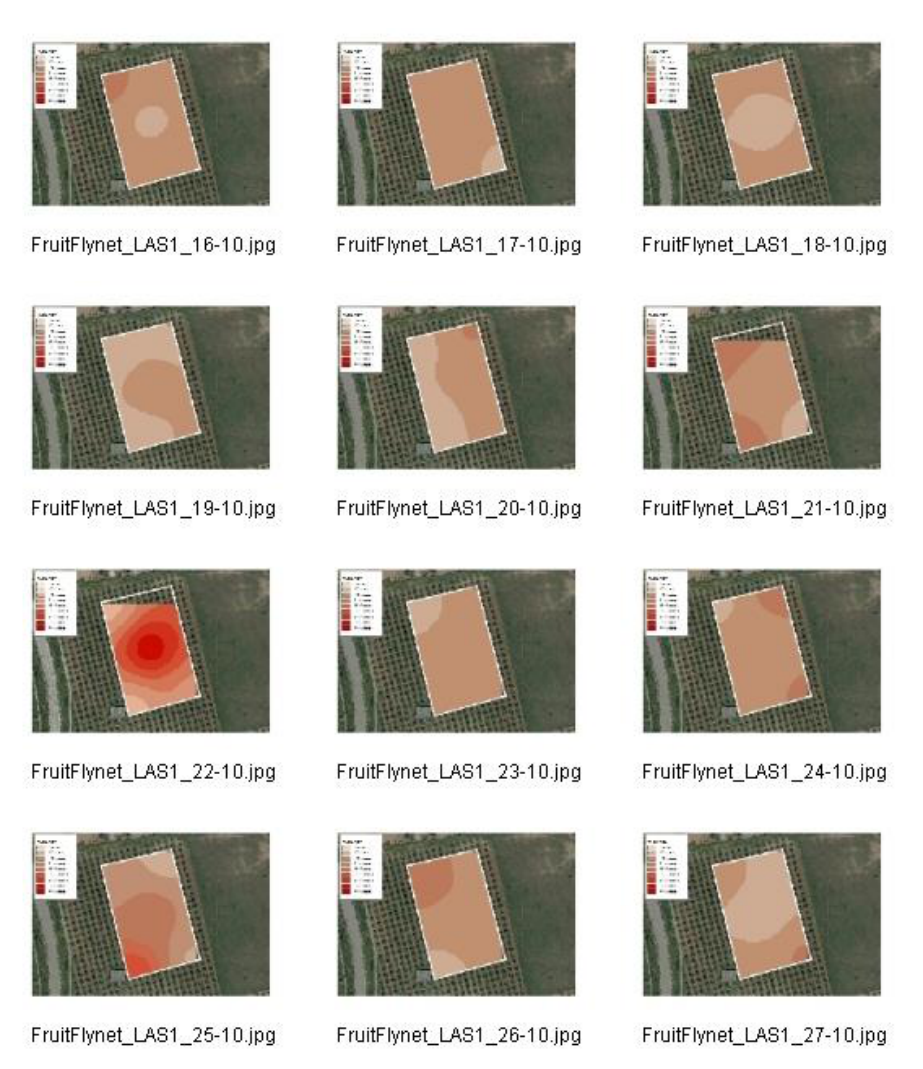
Figure 13. Example of interpolated maps of B. oleae FTD of LAS 1 from 16 to 27 October 2015. Node gaps in interpolations mean no image received from that day. Table 1. Date of treatments, NO-LAS and LAS plots treated, surface treated, and volume of broth sprayed for insecticide treatments. (e): ‘Empeltre’ variety; (p): ‘Picual’